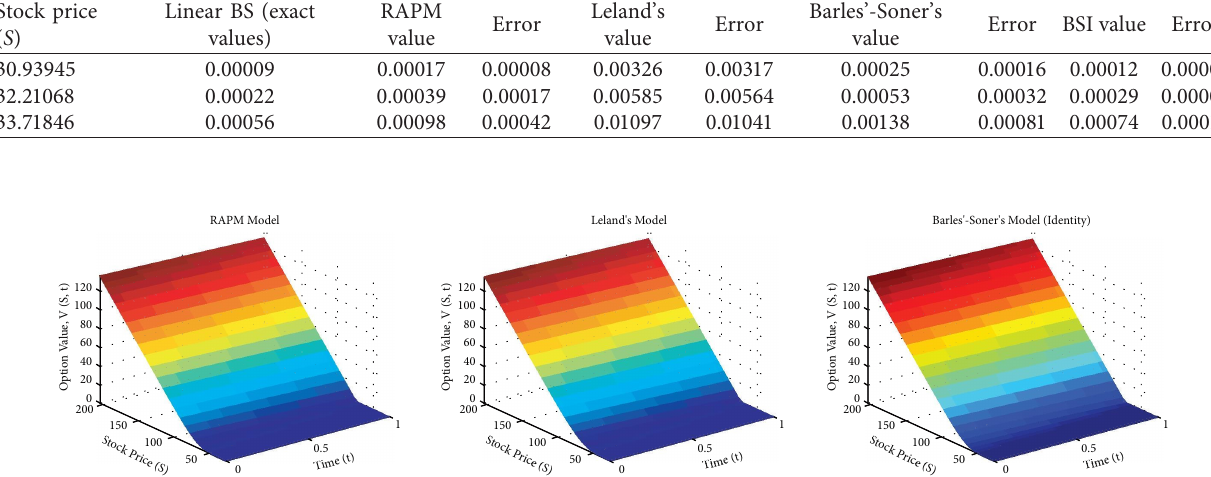
Figure 5: Different types of volatility models by Chebyshev spectral method. Here, we use r � 0 . 1, K � 75, T � 1, σ � 0 . 2, R � 1, N � 40, m � 2500, M � 2, C � 0 . 01, a � 0 . 02, and Le � 0 . 6.